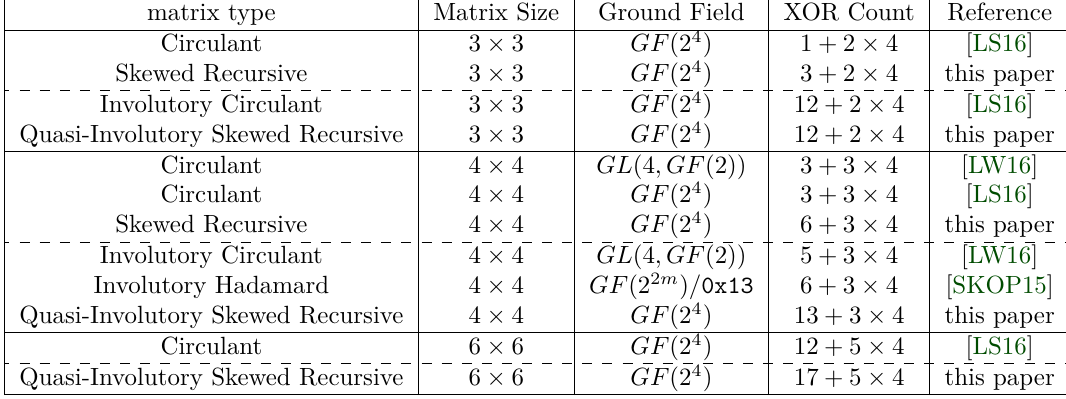
Table 2: Best known MDS matrices with F of a MUX for quasi-involutory